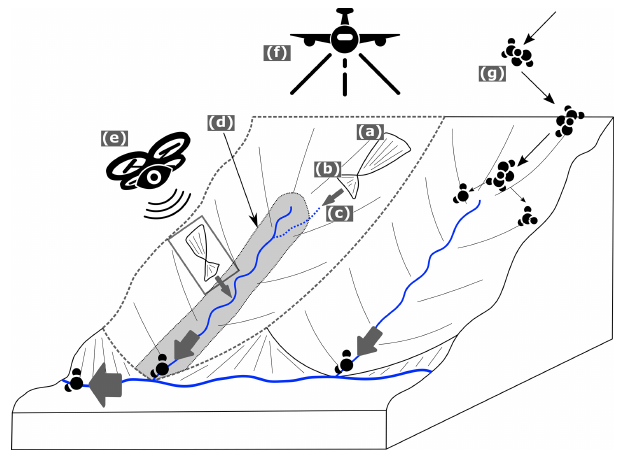
Figure 1. Conceptual framework of the sediment dynamics in Alpine landslide-affected first-order catchments. (a) Landslides are a stochastic process that mobilizes soil and regolith downslope. (b) Landslide-derived material can temporarily be stored on the slopes in landslide colluvial fans, (c) and/or be evacuated by de- bris flows to the fluvial system. (d) Hillslope–channel geomorphic coupling (by, e.g., slope failures induced by river undercutting) is particularly important for understanding the response of the geo- morphic system to sediment pulses. The quantification of sediment fluxes is achieved using (e) UAV-SfM framework, (f) classic pho- togrammetry, and (g) in situ produced cosmogenic